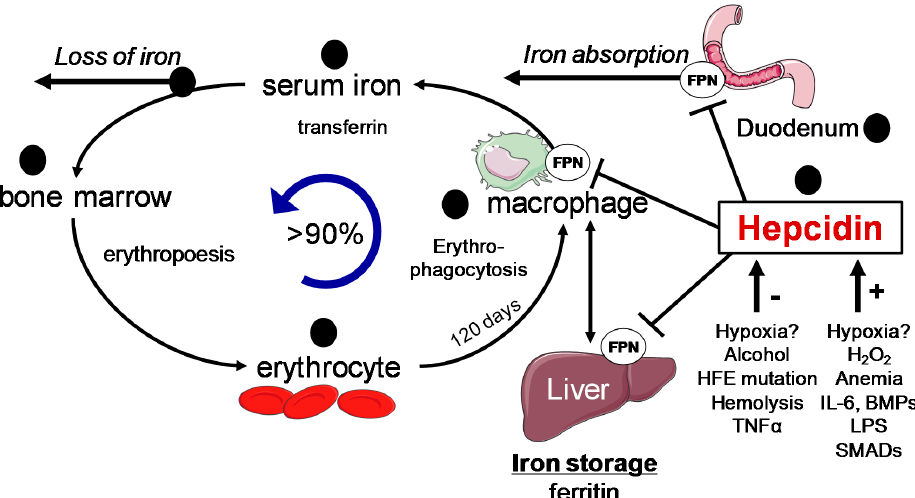
Figure 3. Iron homeostasis and utilization in the body (adapted from [3]). Dietary iron is absorbed in the duodenum and binds to transferrin. Iron is delivered to the bone marrow for erythropoiesis, senescent erythrocytes are phagocytosed by the macrophages, and iron is recycled for heme synthesis. Excess iron is stored in ferritin in the liver. Regulation of iron metabolism by hepcidin and factors which influence hepcidin expression are also shown. Black circles indicate potential sites of alcohol interference. BMP: Bone morphogenic protein; FPN: Ferroportin; HFE: hemochromatosis protein; IL: interleukin; LPS: lipopolysaccharide; SMAD: Suppressor of mothers against decapentaplegic; TNF: Tumor necrosis factor.